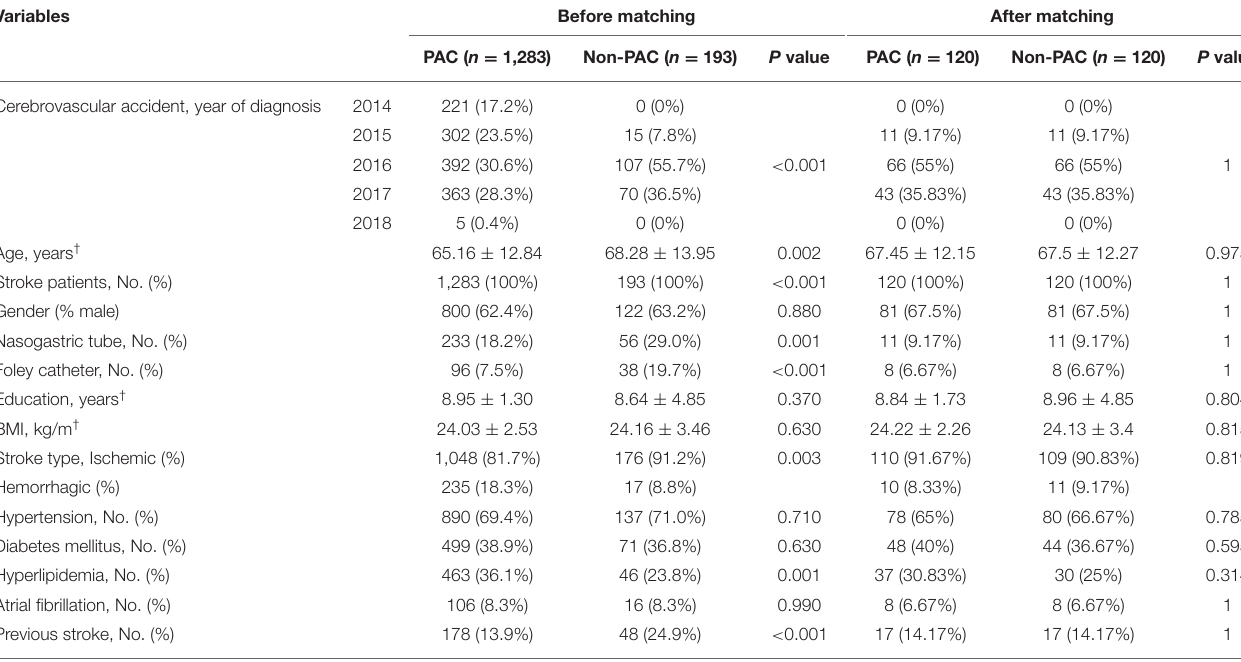
TABLE 1 | Distributions of patient characteristics before and after matching by demographic characteristics and by propensity scores. Variables Before matching